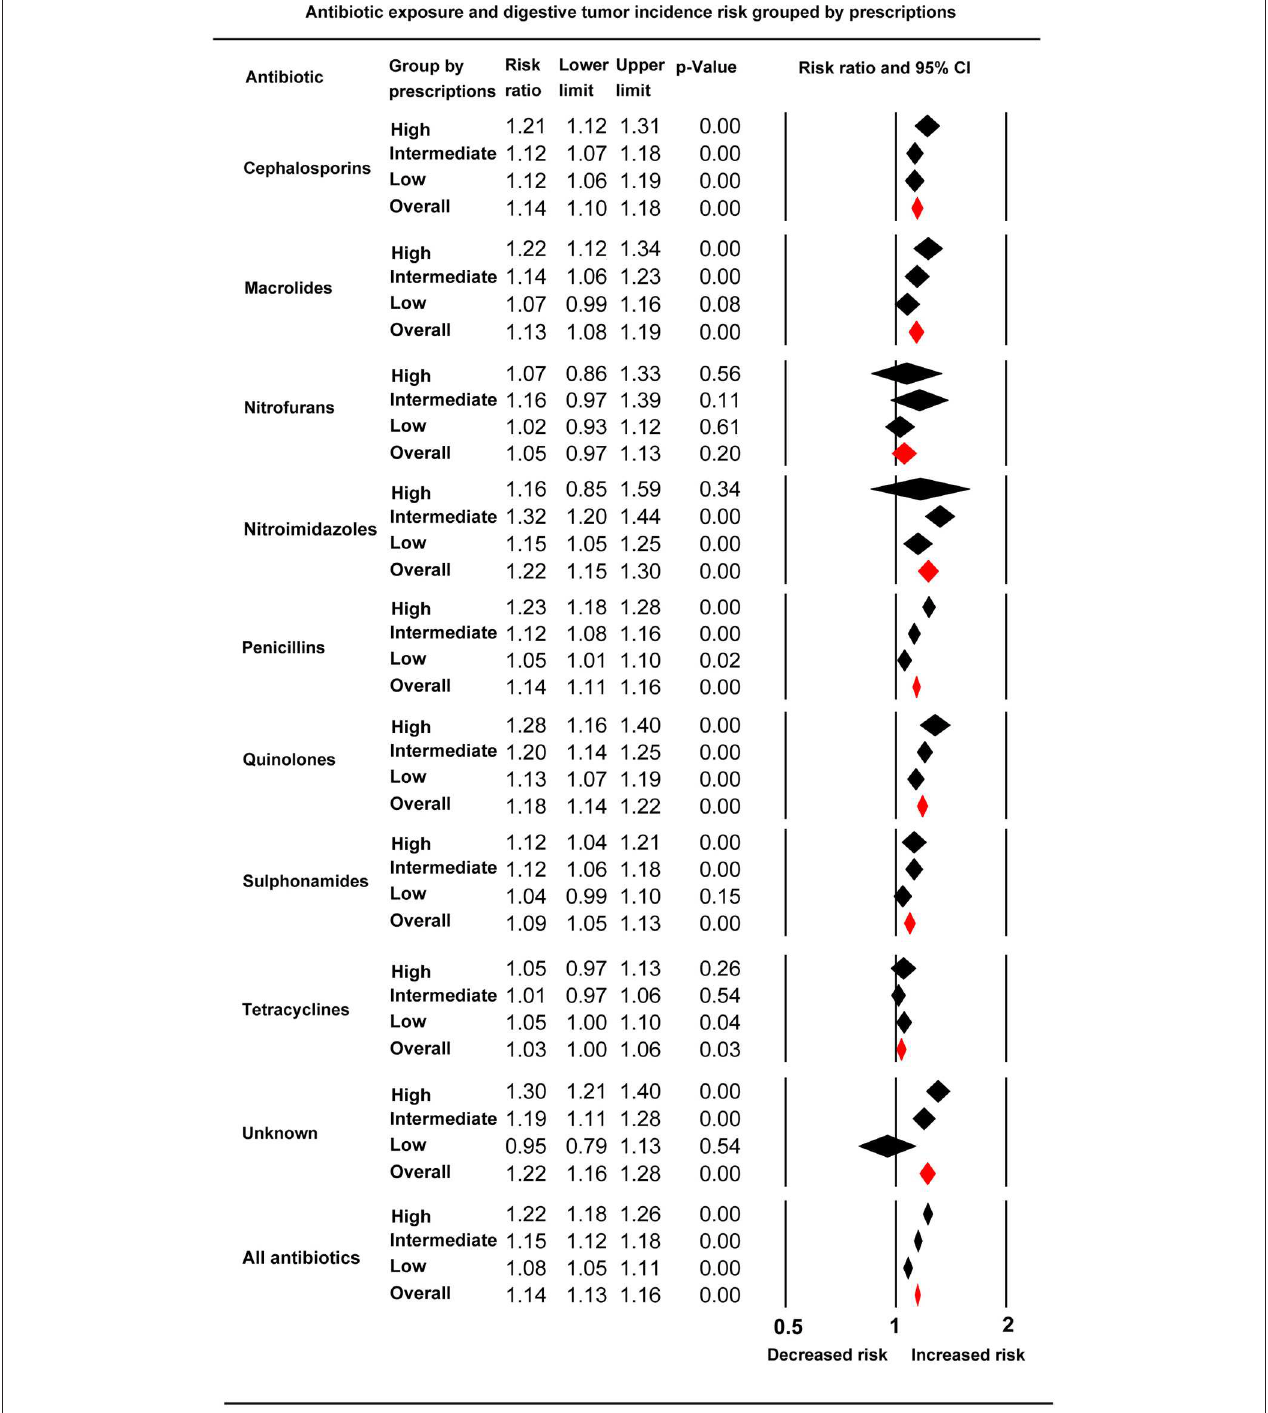
FIGURE 4 | Forest plot of subgroup analysis based on anti-bacterial drug prescription accumulation in each individual anti-bacterial drug class and total anti-bacterial drugs. intestinal microbiota has been associated with the inhibition of carcinogenesis due the important role these microbiota play in the conversion of health-related compounds, such